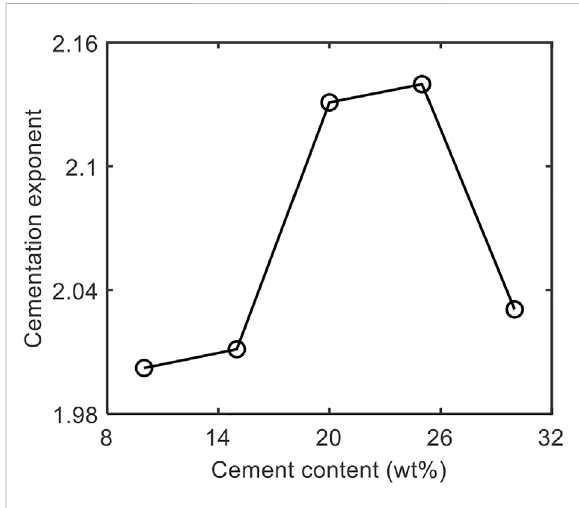
Relationship between cementation exponent and cement content of the samples with approximately the same